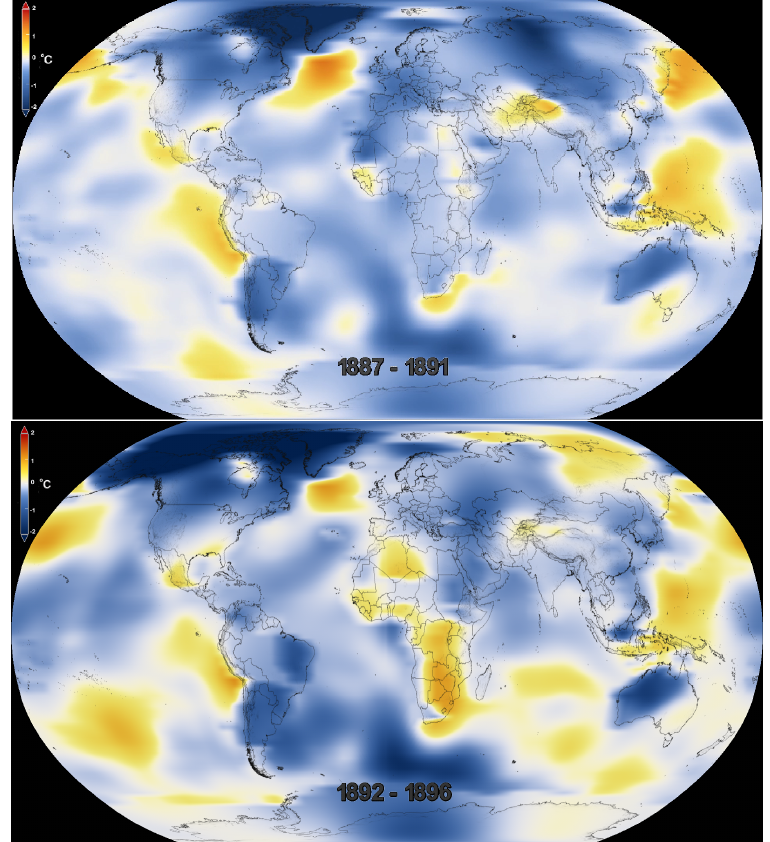
Figure 2. Global Heat concentrations in 1887 ( Top ) and 1892 ( Bottom